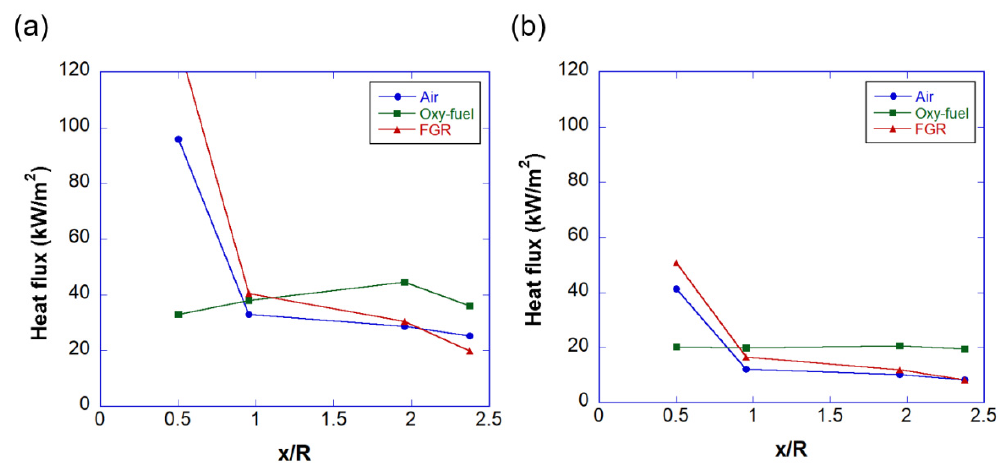
Figure 8. Heat flux to the combustion chamber wall for different combustion modes for ( a ) 100% and ( b ) 50% loads. Figure 9 compares heat flux distributions for different flue gas O 2 for oxy-fuel com- bustion. For 100% load (Figure 9a), the heat flux for 3.5% of O 2 is considerably higher than